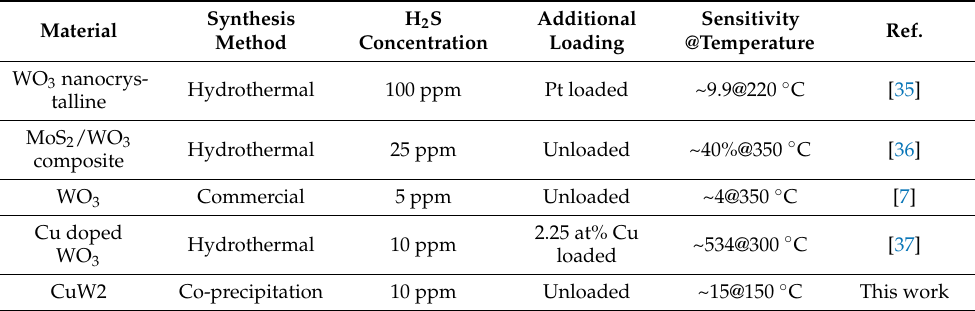
Table 2. Sensitivity to H 2 S with different sensing materials based on tungsten oxide.